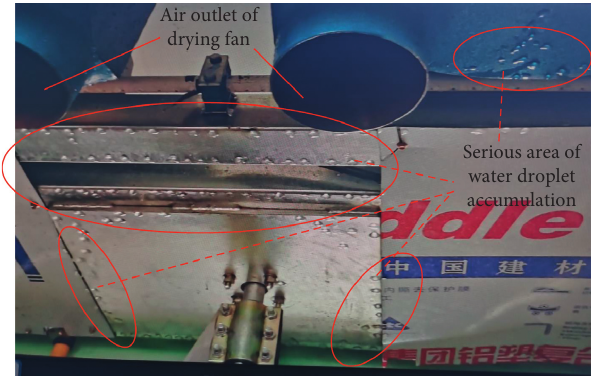
Figure 22: Water accumulation diagram caused by excessive